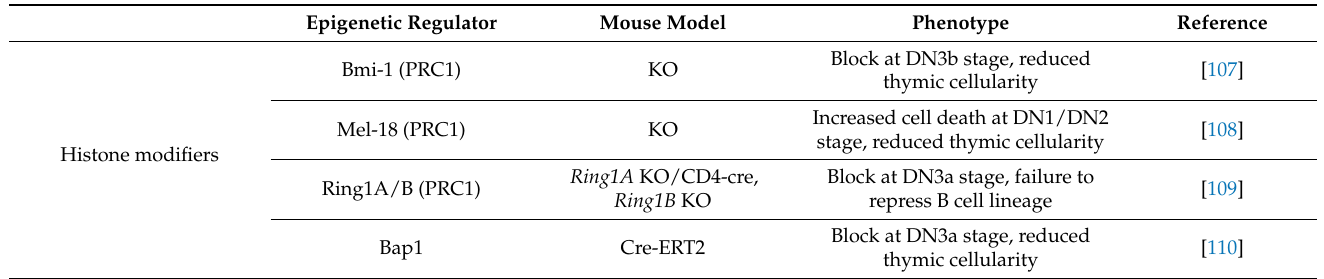
Table 1. Phenotypes of epigenetic factor-depleted murine